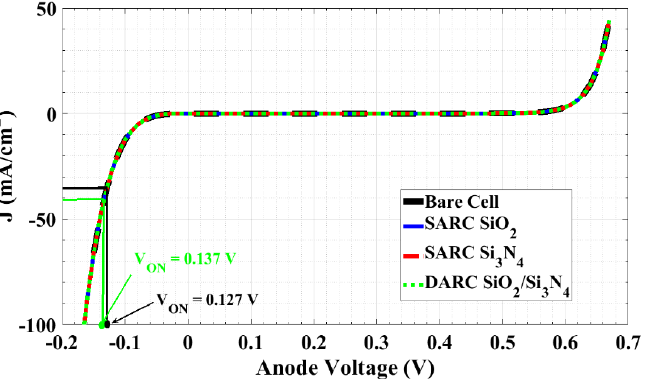
Figure 12. Dark J-V Characteristics for bare cell, SARC of silicon oxide, SARC of silicon nitride, and DARC of silicon oxide/silicon nitride.